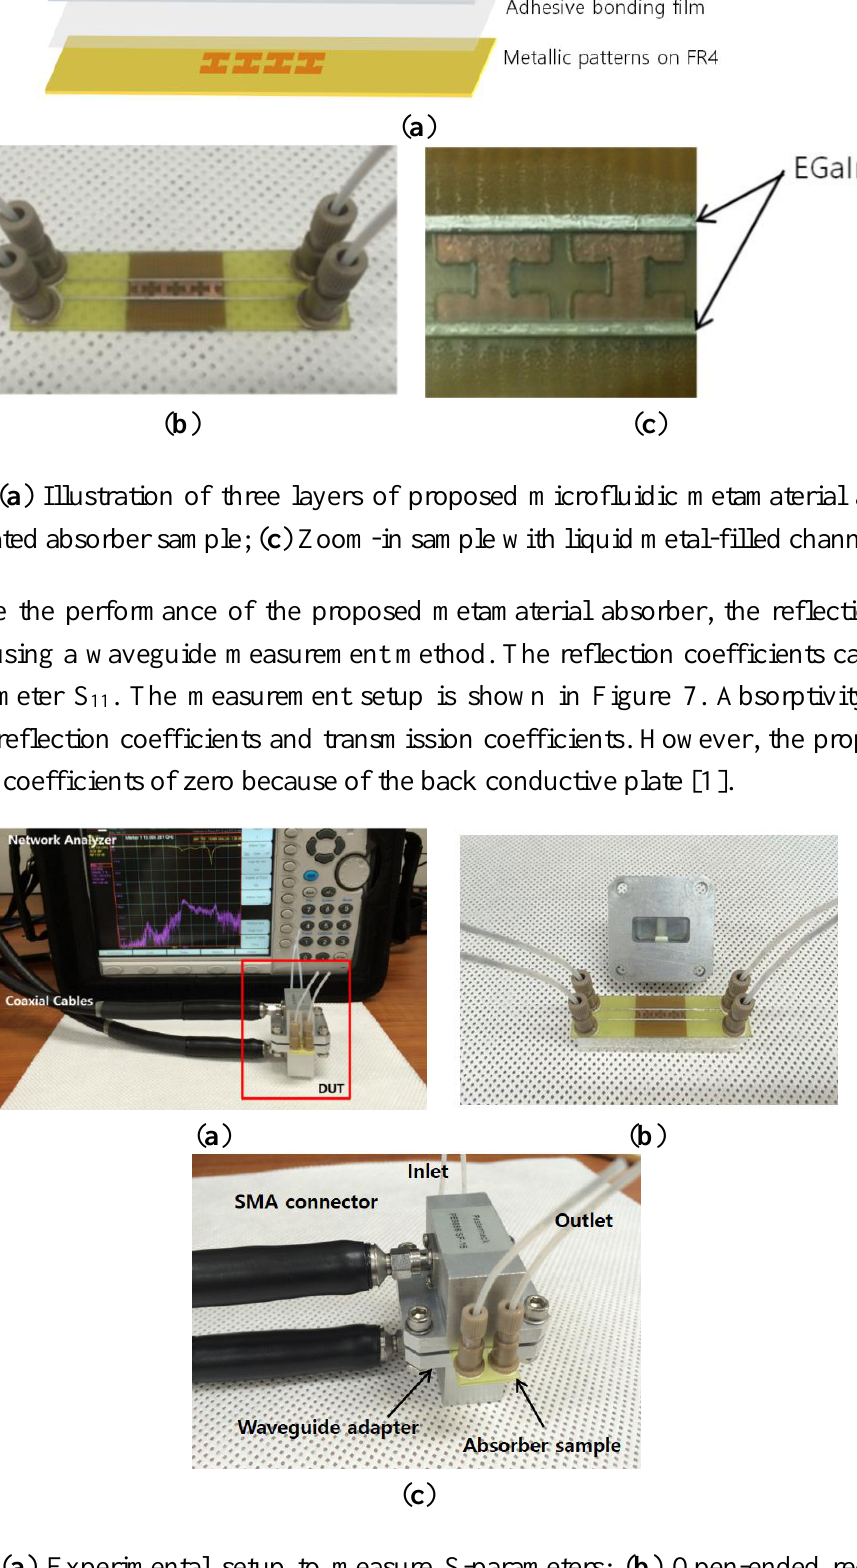
Figure 7. ( a ) Experimental setup to measure S-parameters; ( b ) Open-ended rectangular waveguide; ( c ) The fabricated sample with two SMA-to-waveguide